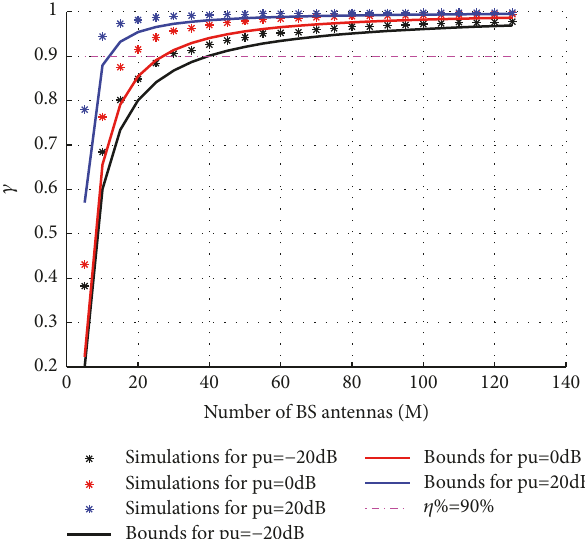
Figure 3: Lower bounds and numerically simulation results of 𝛾 versus different numbers of BS antennas with different transmit SNR.